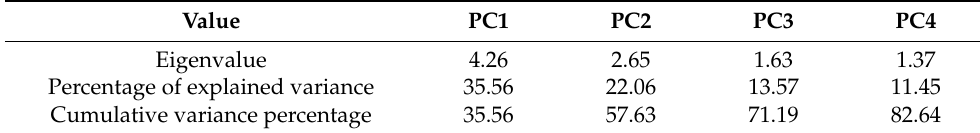
Table 7. Eigenvalue and percentage of variances retained by principal components that de- scribe the resistance mechanisms of the 11 races of maize to Tetranychus merganser at 24 h under laboratory